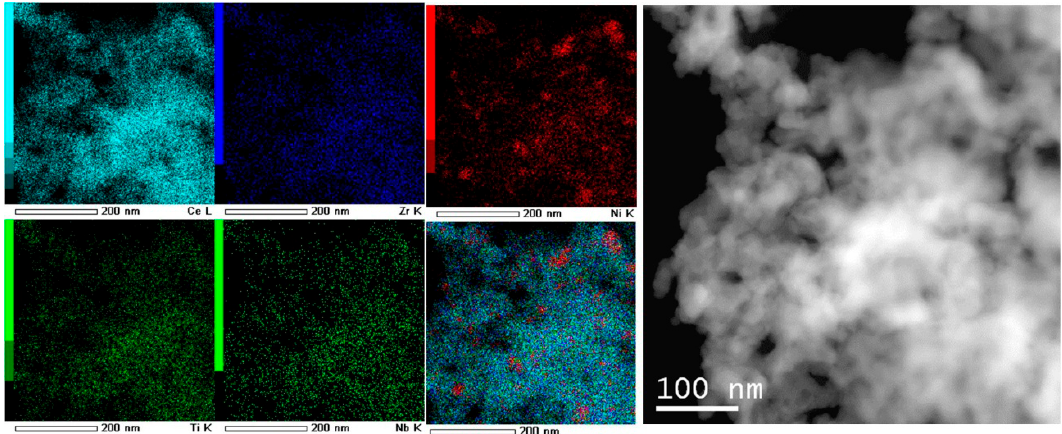
Figure 10. HAADF-STEM image with EDX analysis of catalyst Ni-CeTiNbZr prepared by citrate route.